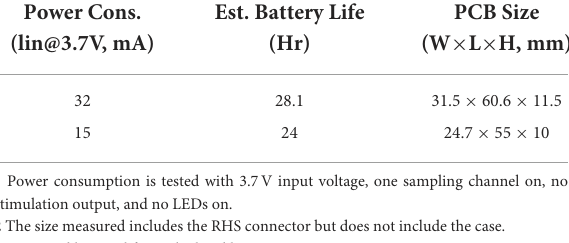
TABLE 2 Tradeoff between size and battery capacitance. Power